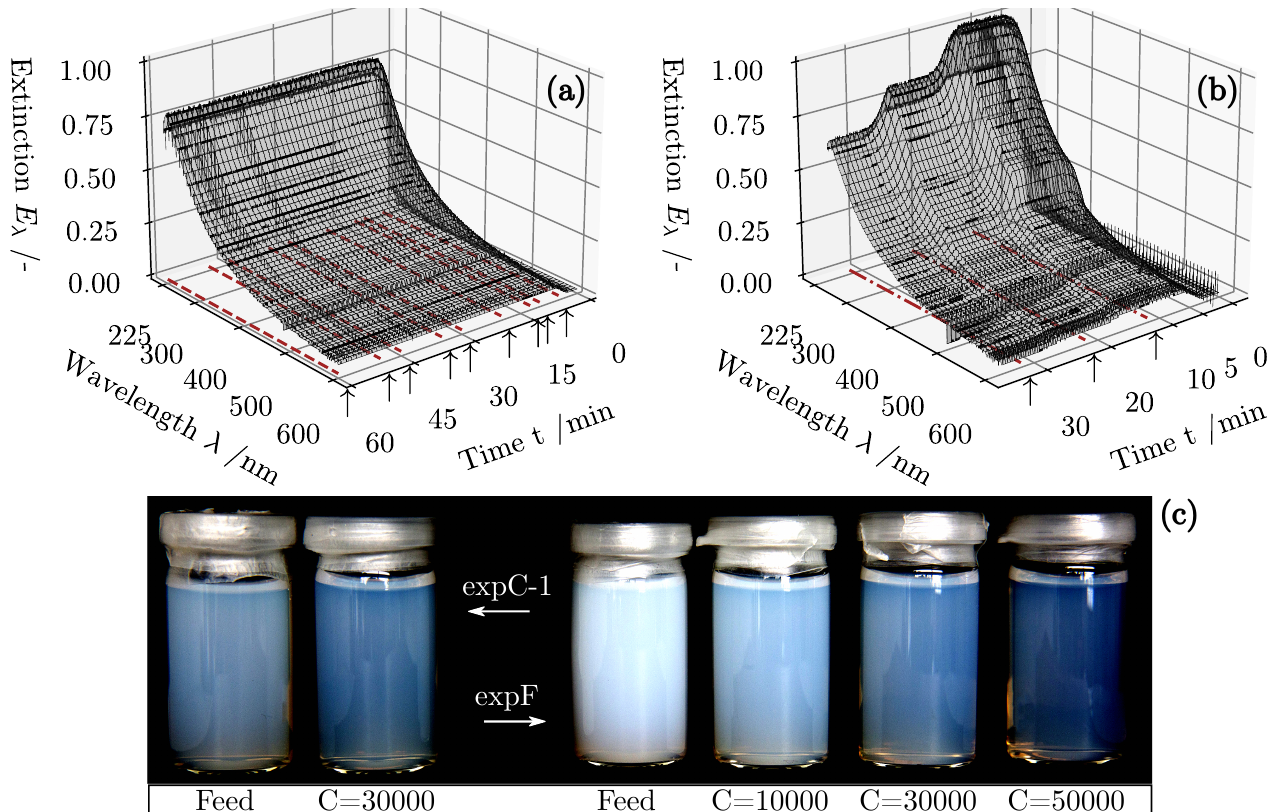
Figure 8. Raw extinction data of experimental series expC-1 ( a ) and expF ( b ) measured with the experimental setup (Figure 4b) of the UV/vis hardware sensor. Arrows and dash dotted lines mark sampling times. ( c ) Collected overflow samples at constant C -values and plateaus of extinction. Feed samples visualized for comparison between transmittance before and after